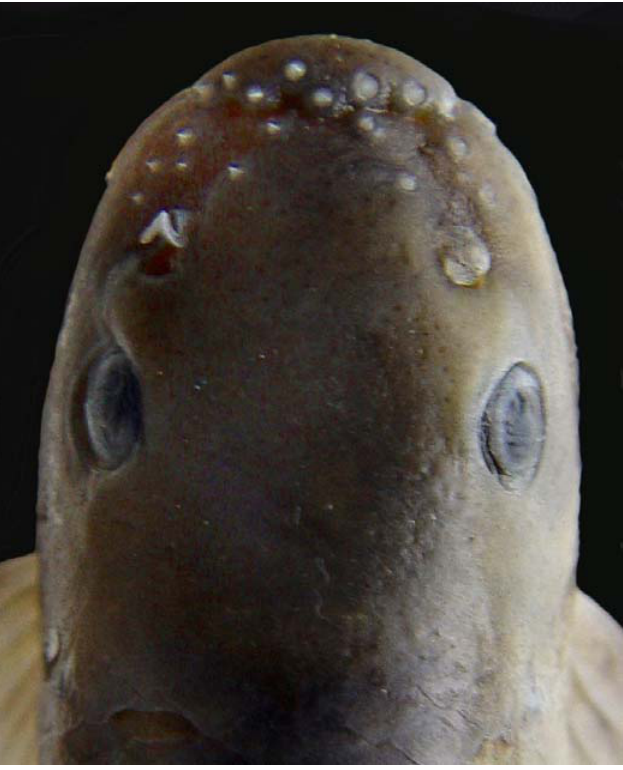
Image 3. Garra arupi sp. nov. Dorsal view of head of holotype